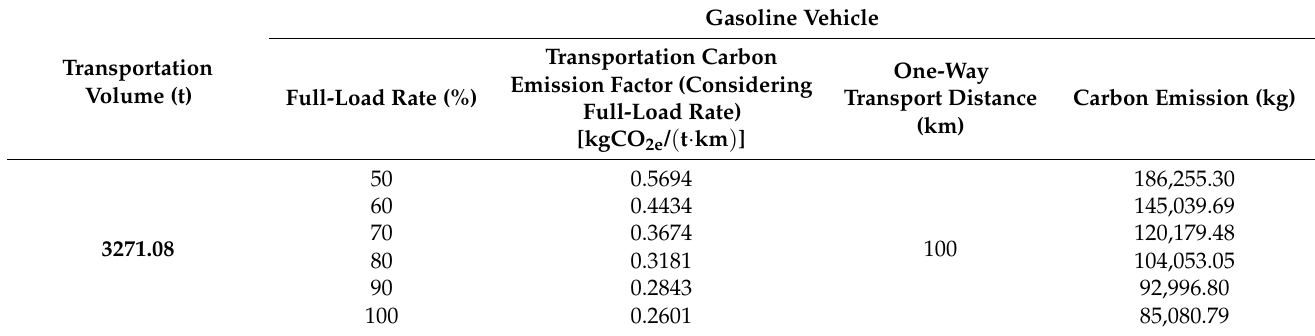
Table 8. Carbon emissions from the transportation of prefabricated components under the influence of different full-load rates.